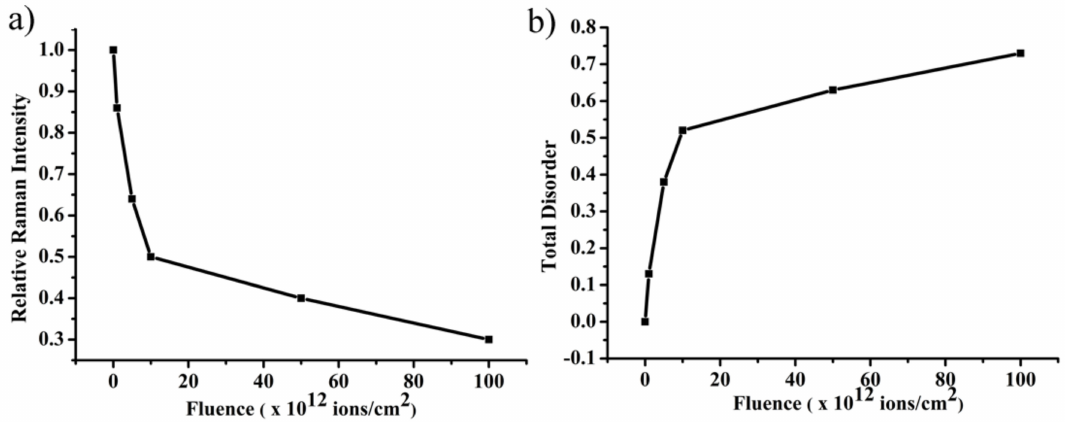
ion-implanted samples; ( b ) Raman spectra of the sample implanted at fluence 1 × 10 14 ions / cm 2 .